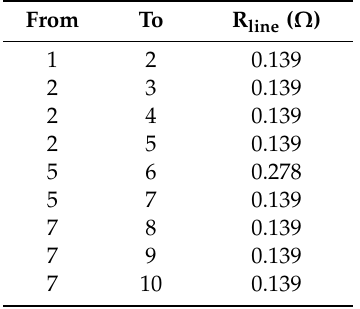
Table 2. MVDC network line parameters.